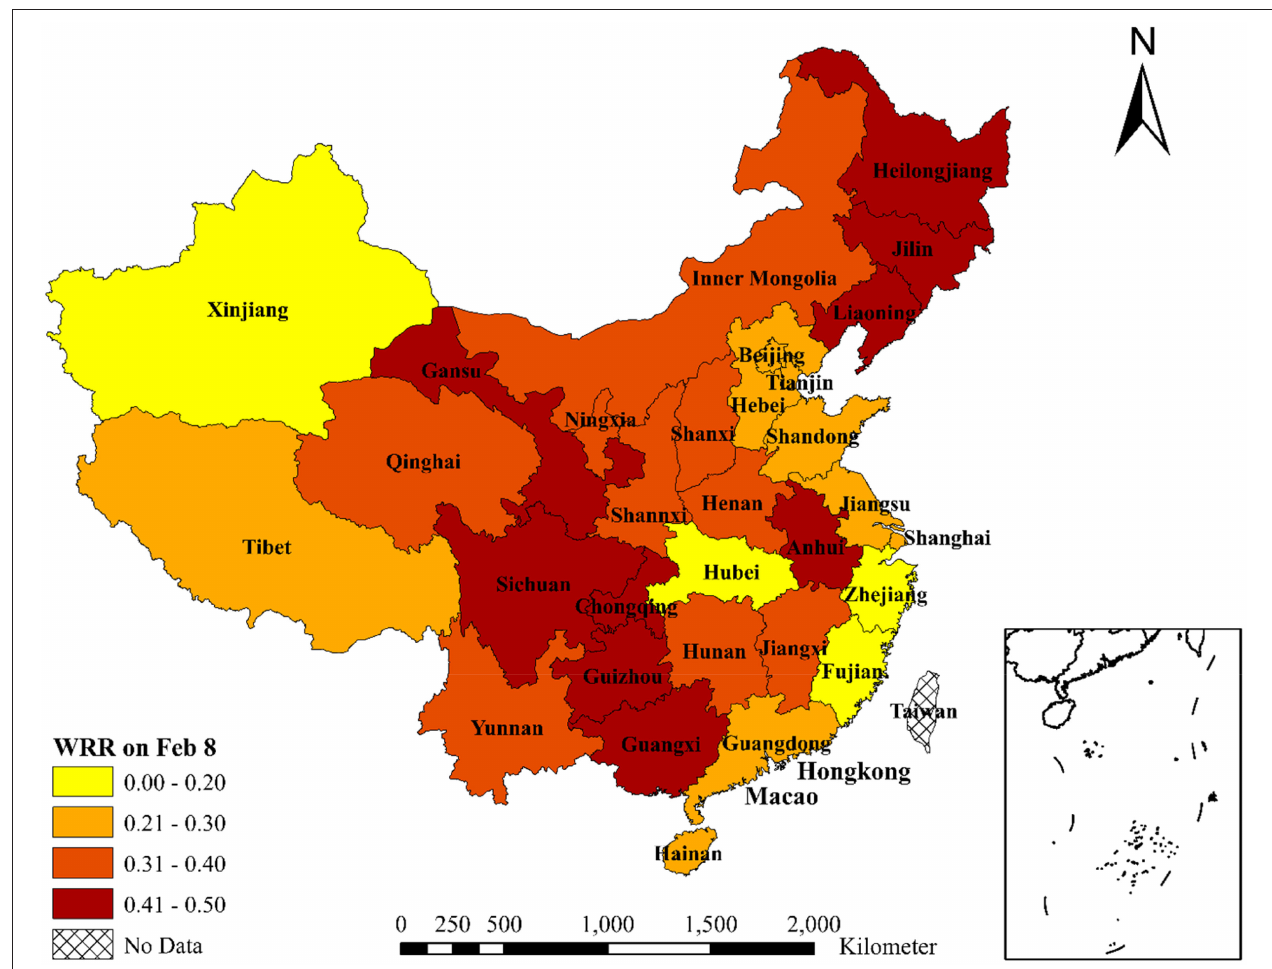
FIGURE 3 | WRR of 31 Chinese provinces on February 8, 2020. This figure shows the work resumption rate (WRR) of 31 provinces in China on February 8, 2020 (i.e., Chinese Lantern Festival). For WRR on Feb 8, t 1 is January 25, 2020 and t 2 is February 8, 2020; t ′ 1 is January 10, 2020 and t ′ 2 is January 24,